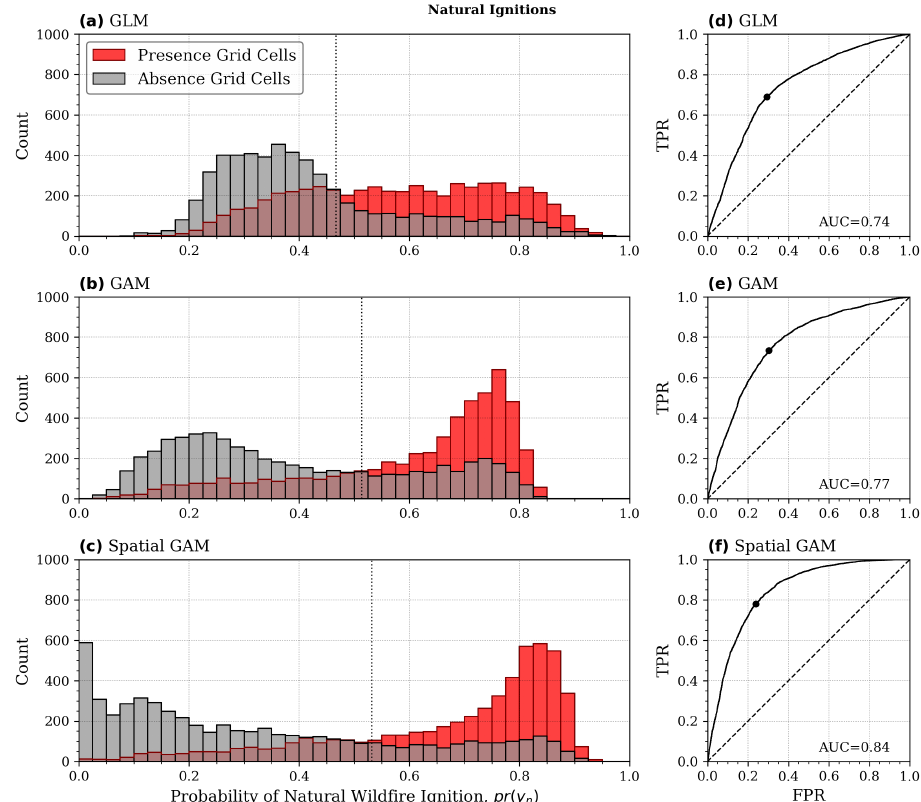
Figure 5. Evaluation of the multiple logistic general linear model (GLM), general additive model (GAM), and spatial-GAM used to model natural wildfire ignition probability. Model definitions are shown in Table 1. Each model was applied to the held-back testing datasets and the frequency distributions shown in ( a – c ) indicate the count of presence (red) and absence (black) grid cells according to their predicted probability. The receiver operating characteristic (ROC) curves and area under the ROC curves (AUC) shown in ( d – f ) were also generated from the testing datasets. The optimum probability thresholds (i.e., closest to TPR = 1.0 and FPR = 0.0) are shown as dotted vertical lines in ( a – c ) and solid circles in ( d – f